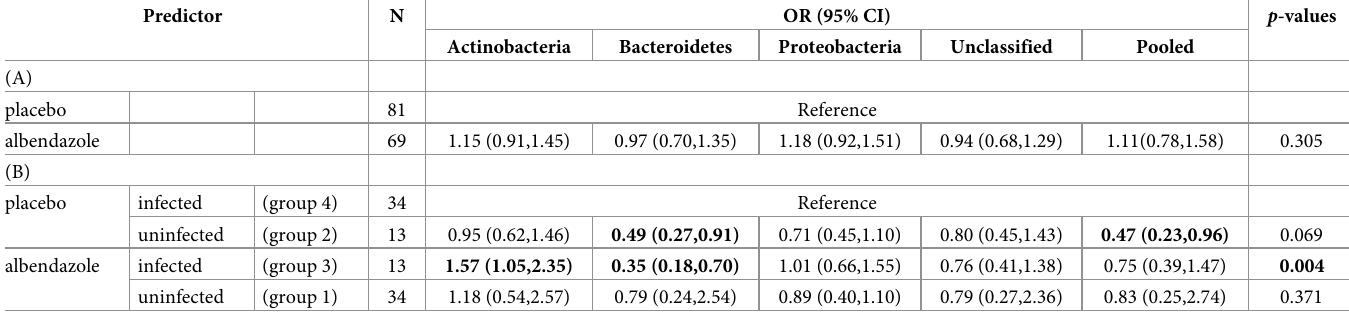
Table 2. The association between each bacteria phylum with treatment and infection at post-treatment.